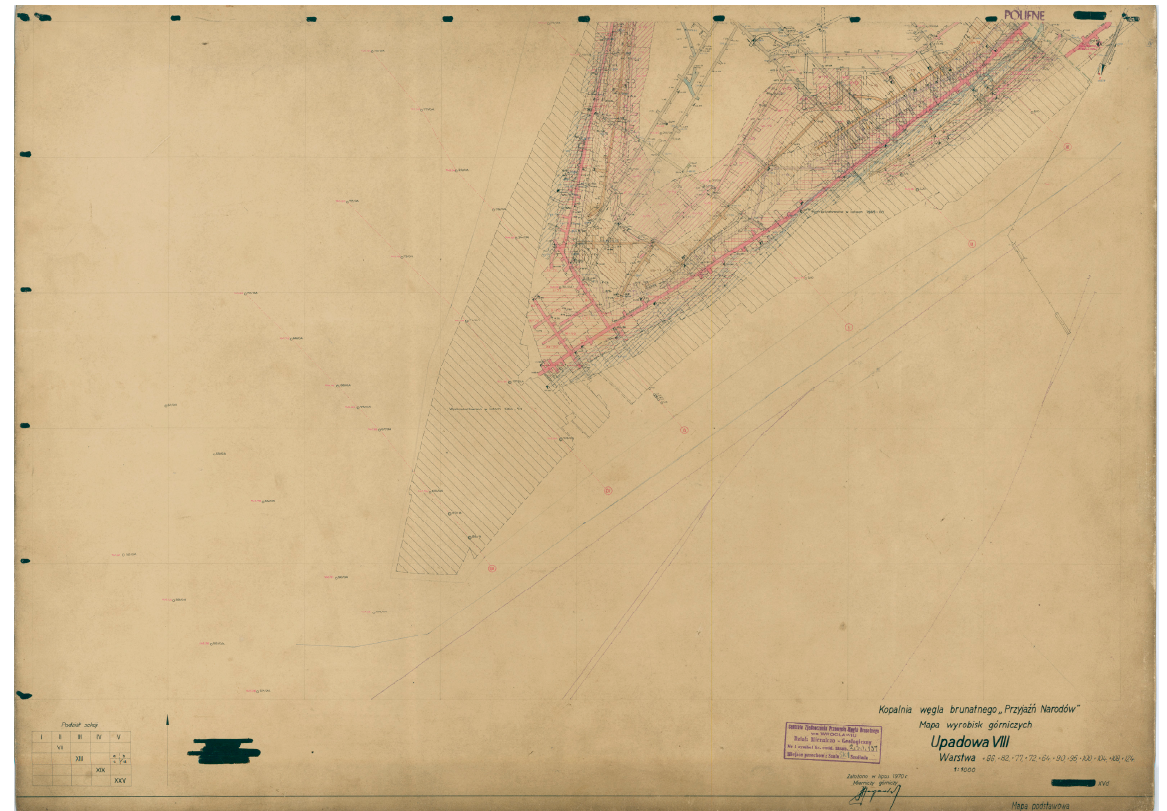
Figure 4. An example of source documentation; a section of mining map depicting underground workings.